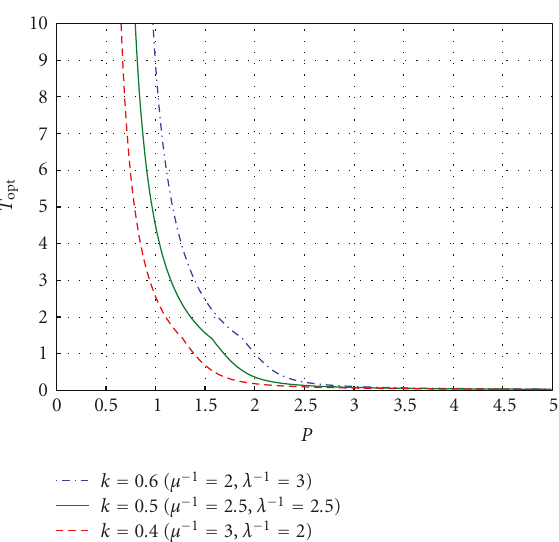
Figure 9: The optimal T opt under policy π 2 for di ff erent k.